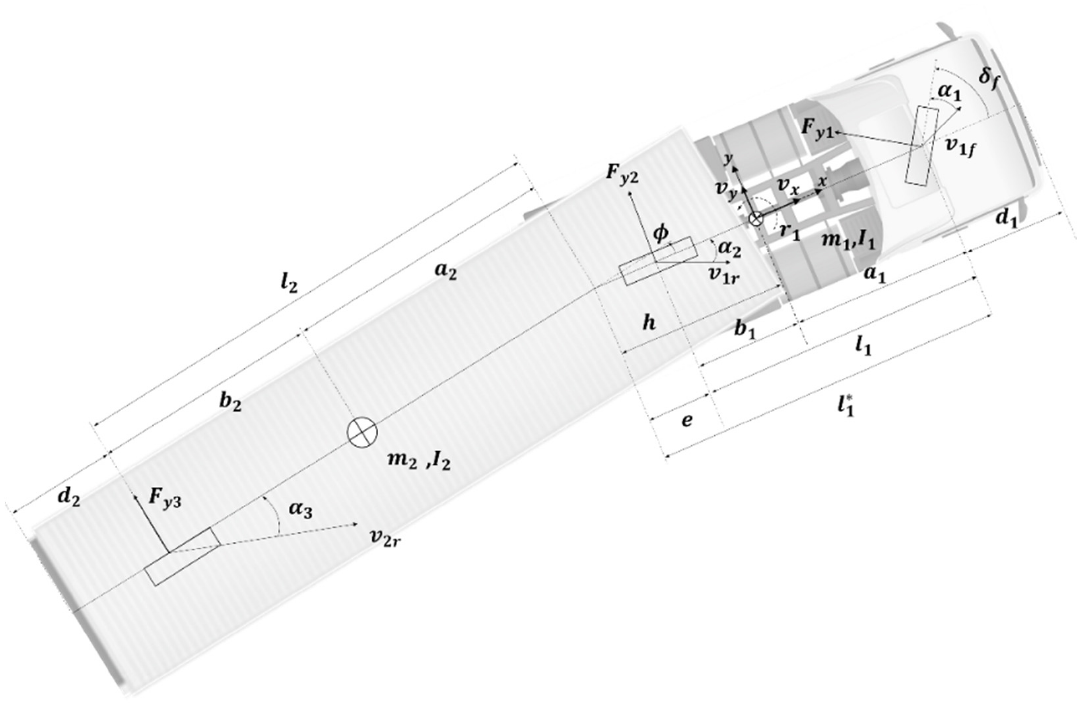
Figure 8. 3 degrees of freedom articulated vehicle model.